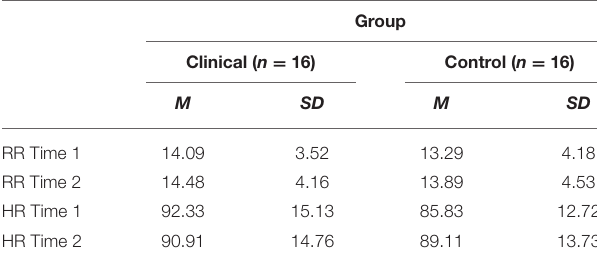
TABLE 5 | Descriptive statistics for time 1 and time 2 of the CO 2 challenge.